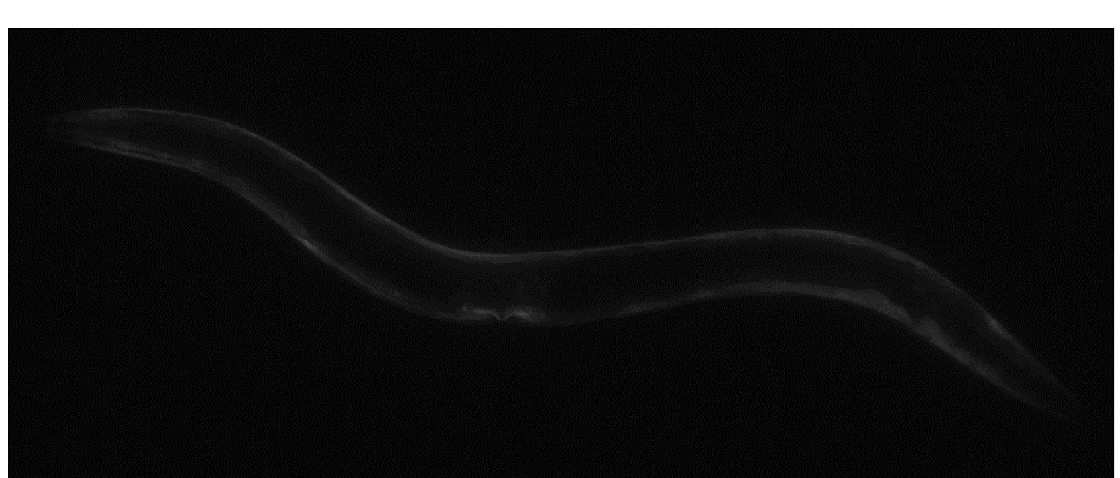
Fig 8. GFP fluorescence captured at 30 fps. Image composed of two pictures stitched together to obtain a wider view. Transgenic animal expressing myo-3p :: GFP has been used.